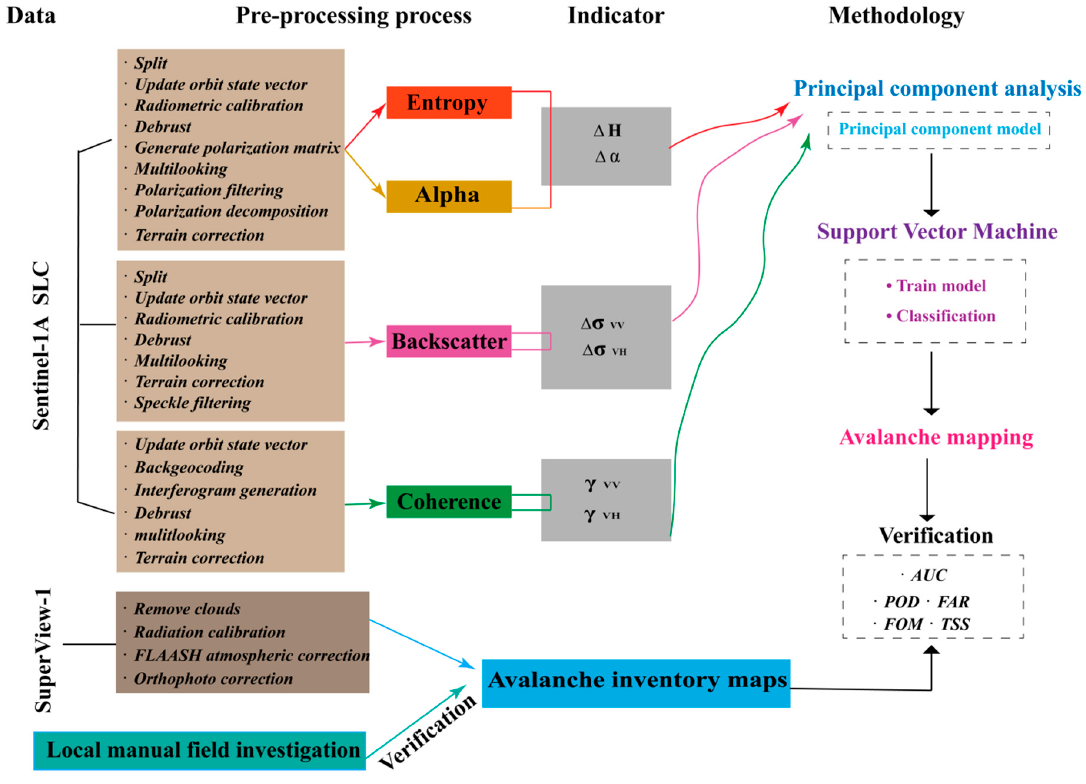
Figure 2. Schematic diagram of the overall workflow.